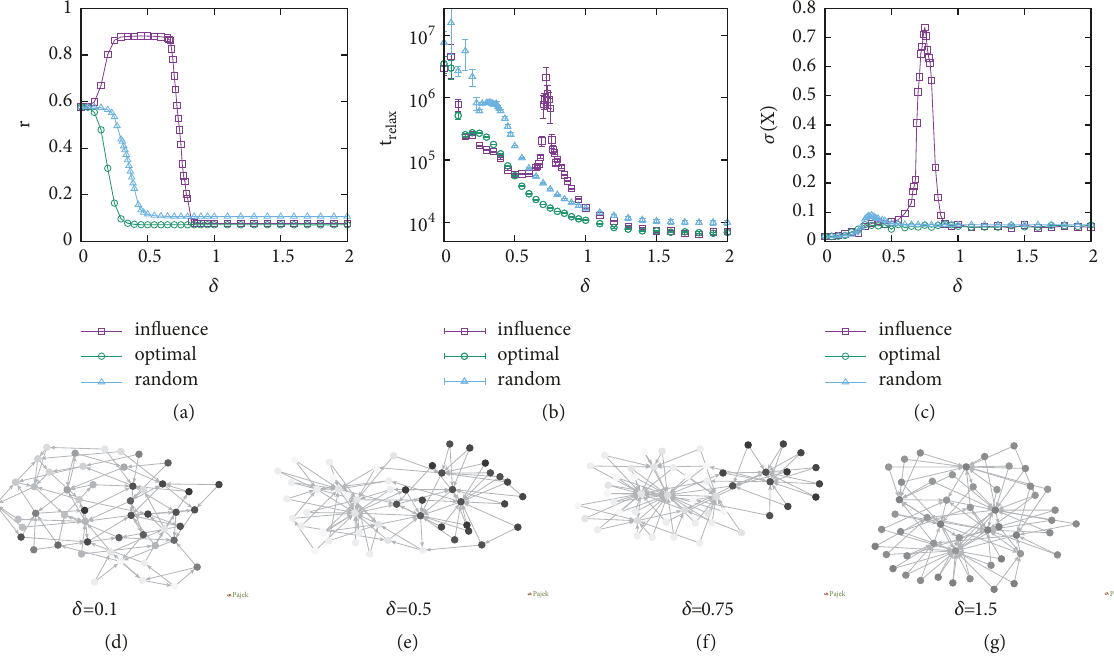
Figure 2: Dependenceof outcomesof theadaptive influencedynamics on 훿 for a scenarioof all agents attemptingtomaximize theirinfluence on the system: (a) opinion dispersion, (b) relaxationtimes, and (c) standard deviation 휎(푋) of the averageopinion X atthe end of simulations. The figures compare three different settings for rewiring: competitive influencemaximization (influence),rewiring to reduce 푟 (optimal), and random rewiring (random). Results are averaged over 50 independent runs for a system of 푁 = 1000 nodes, noise Δ = 0.001 , ⟨푘⟩ = 10 , and 푚 = 3 . The bottom row visualizes typical evolved networks of size 푁 = 50 with ⟨푘⟩ = 4 for 훿 = 0.1 (left most), 훿 = 0.5 (2nd from left), 훿 = 0.75 (third from left), and 훿 = 1.5 (right). Nodes are coloured according to their opinions with light gray corresponding to 푥 = −1 , gray to 푥 = 0 , and black to 푥 = 1